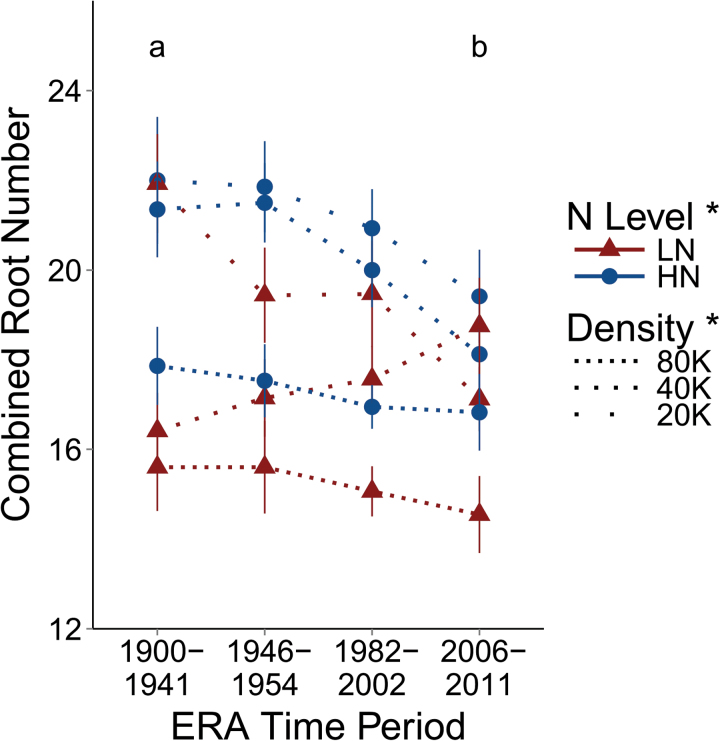
Combined root number adds brace root number and crown root number. Dotted lines represent planting density, with gaps between dots being proportional to differences in densities, with 20K, 40K, and 80K being 20 000, 40 000, and 80 000 plants ha–1. Triangles are in low nitrogen (LN) and circles in high nitrogen (HN). Points represent the mean of the four varieties in that Era time period in the specific N and density combination, and vertical lines the standard error. Letters demonstrate a significant difference between the first and last Era periods based on a t-test (P=0.01541) conducted after ANOVA demonstrated a significant effect of Era period. Presence or absence of an asterisk next to a treatment in the key indicates whether a treatment effect is significant or not, respectively. (This figure is available in colour at JXB online.)